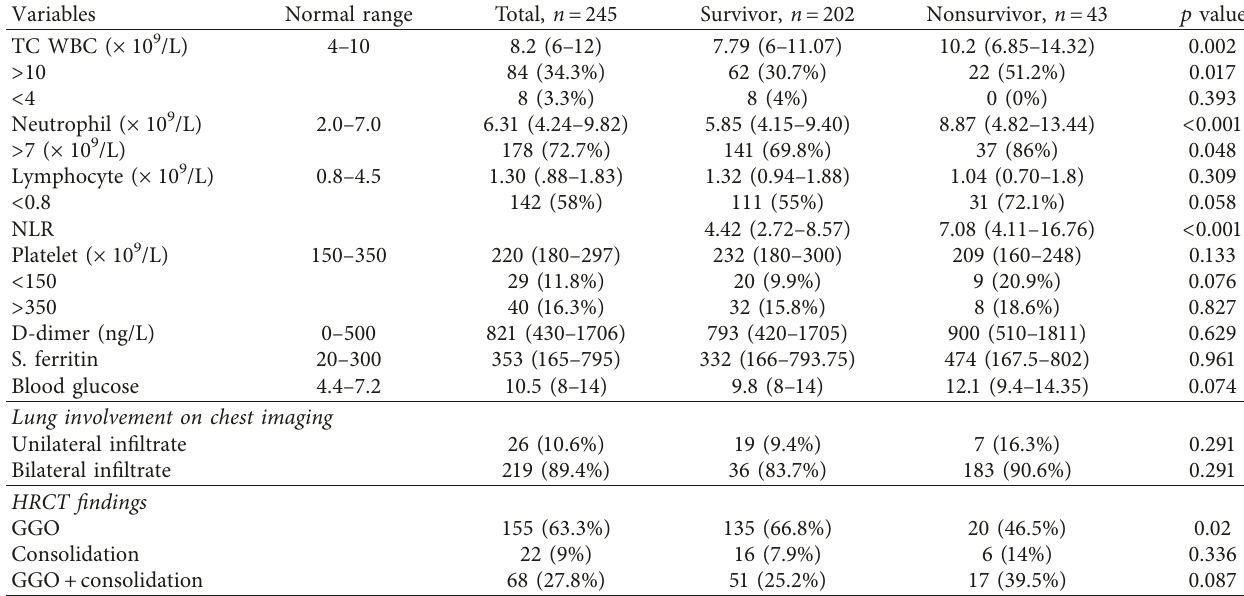
Table 2: Radiology and laboratory findings (median (IQR)/number